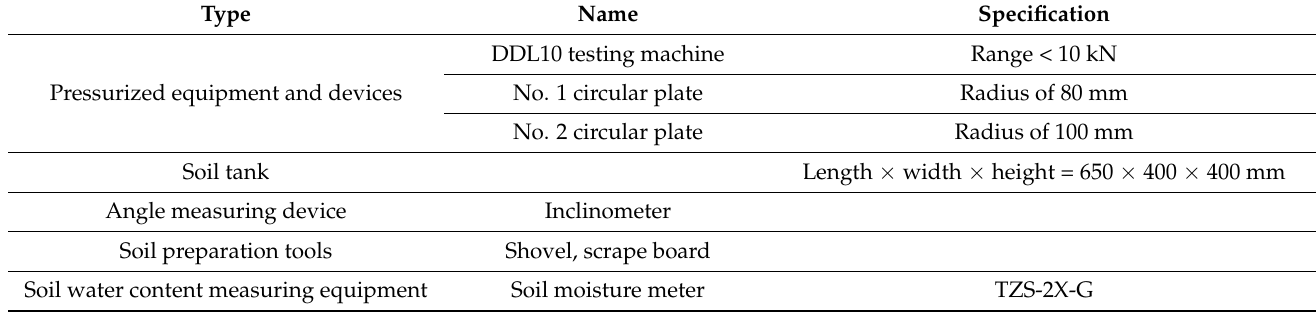
Table 3. Pressure–sinkage test equipment under sloped conditions.